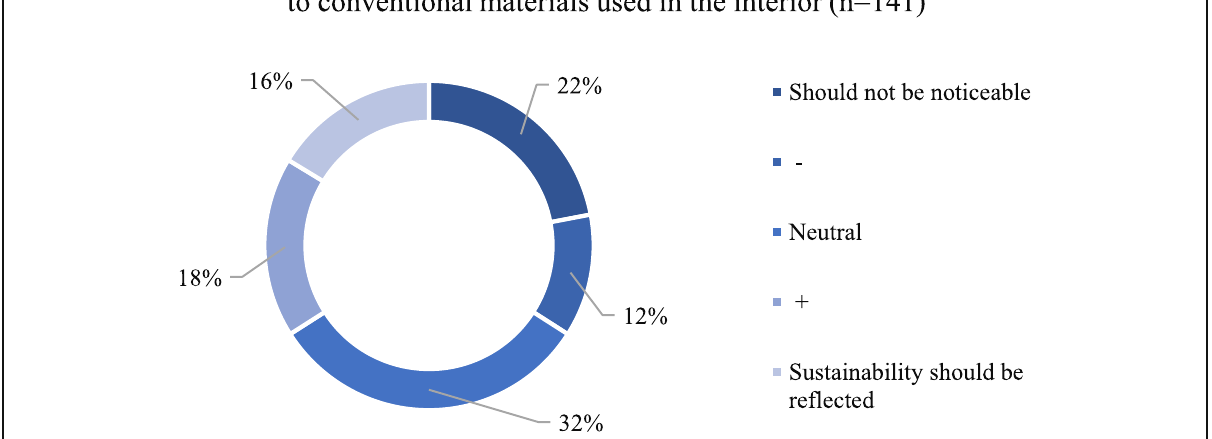
Fig. 9 Assessment of the perceptibility of natural materials in the interior. Source: Own illustration